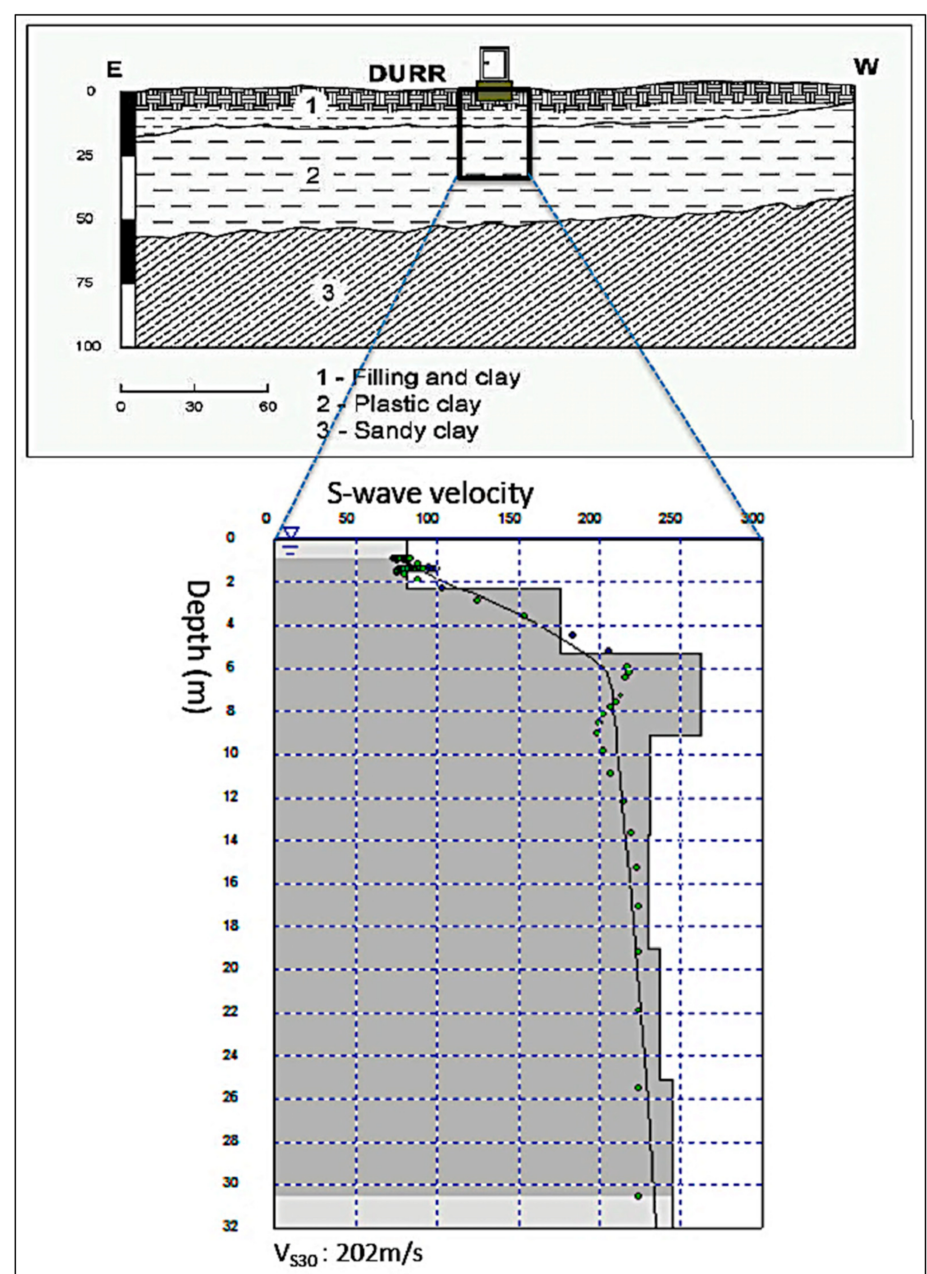
Figure 8. East-west cross section and lithology ( upper ); V s profile of the DURR station for the upper 30 m ( lower